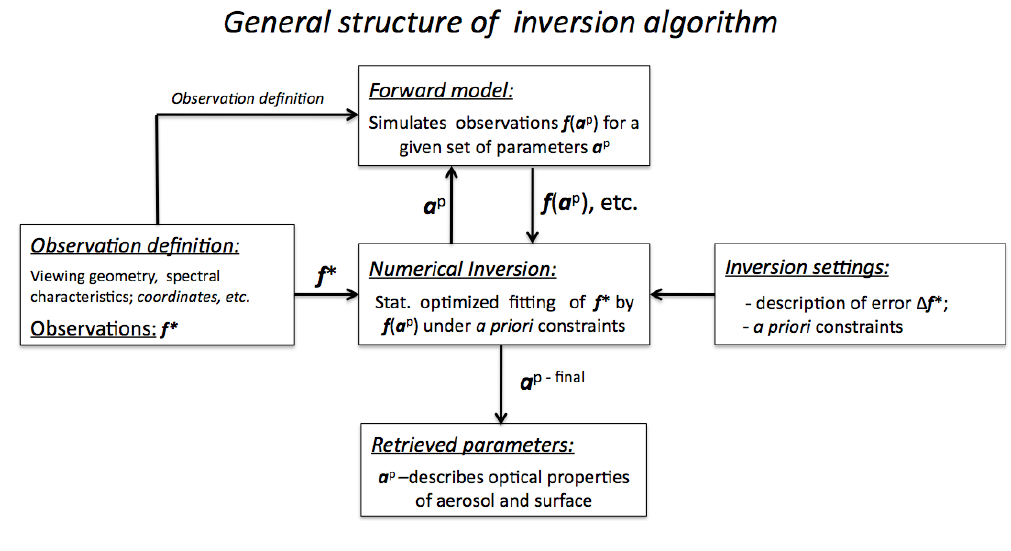
Fig. 1. The general structure of the retrieval algorithm.